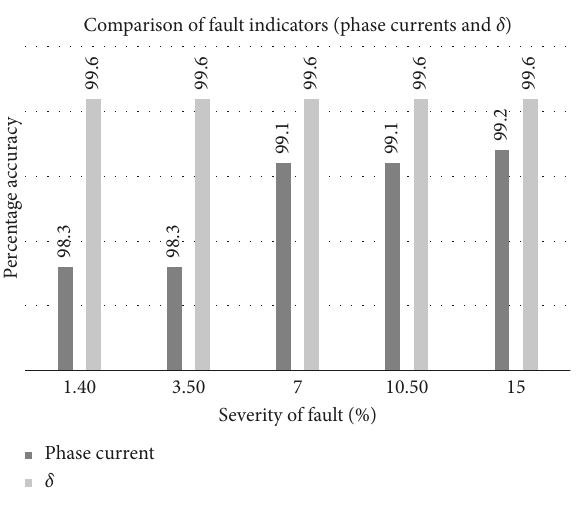
Figure 6: Comparison between fault